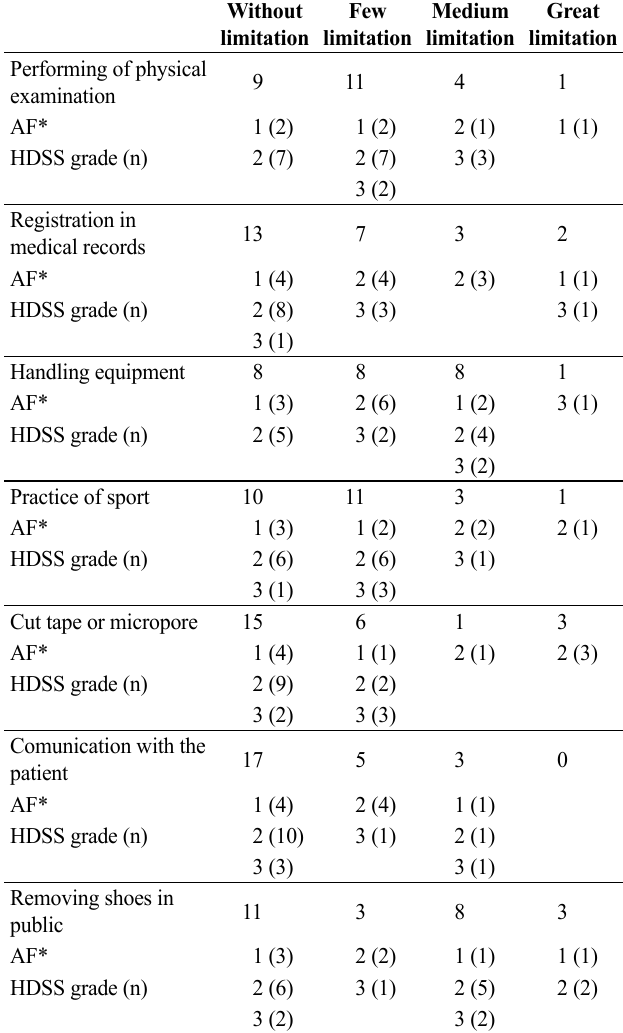
Table 2: Distribution of work-related limitations related to PH’s lev- el, reported by the 25 academics with primary hyperhidrosis of